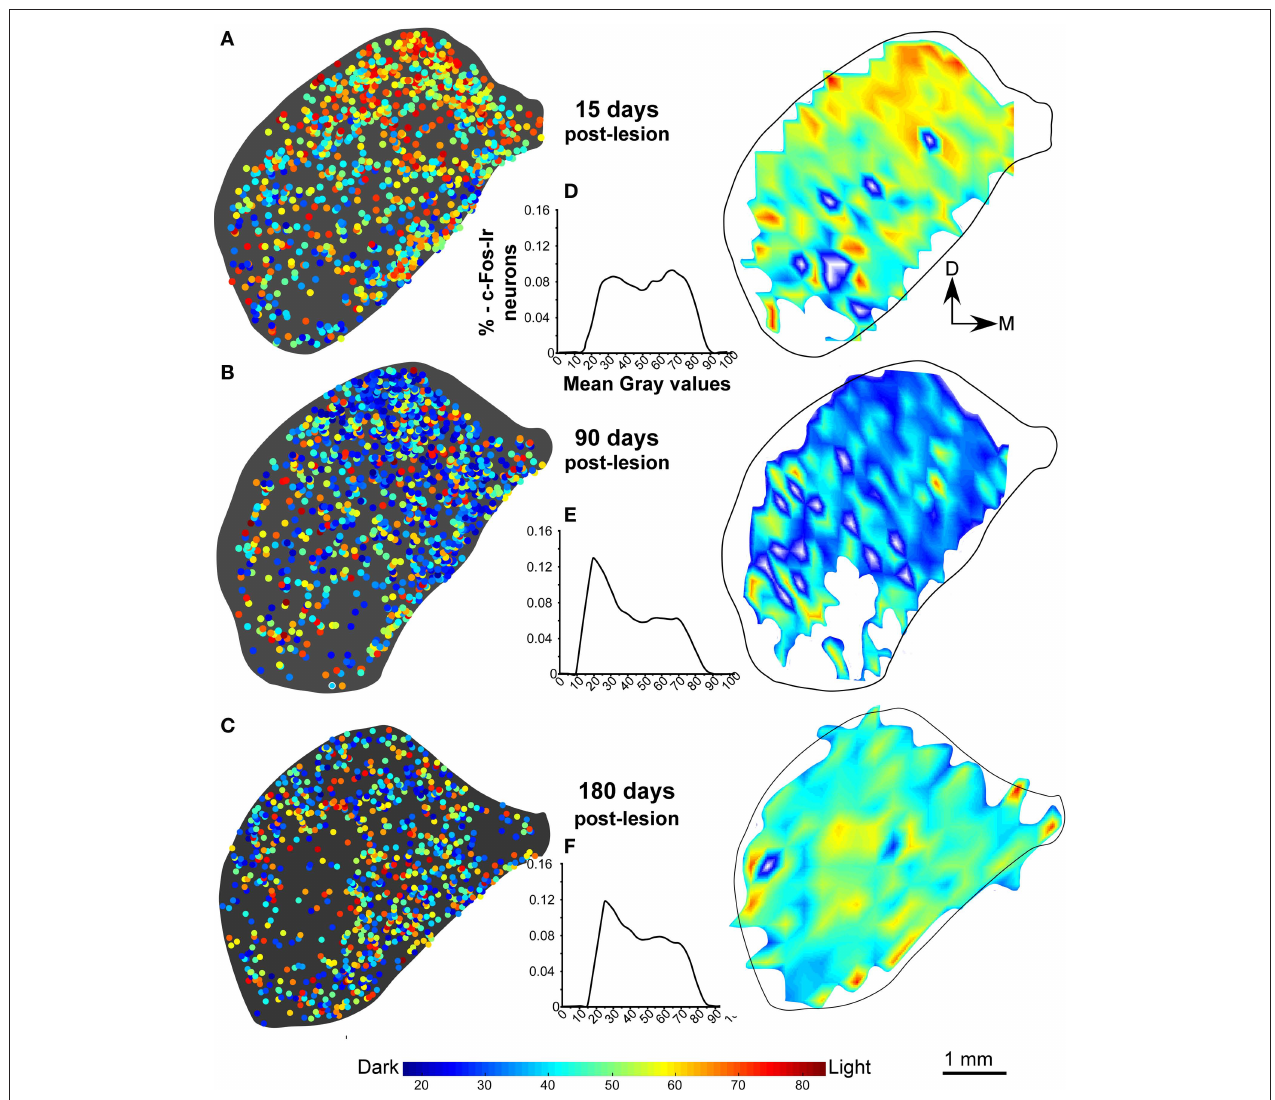
Figure 4 | Distribution density and gray value plots of c-Fos immunoreactive nuclei in representative sections of the inferior colliculus after sound stimulation. (A) After 15 days post-lesion, values continue to be lower than the in the stimulated control group (B,C) c-Fos labeling densities are comparable to those in controls after sound stimulation 90 days (B) and